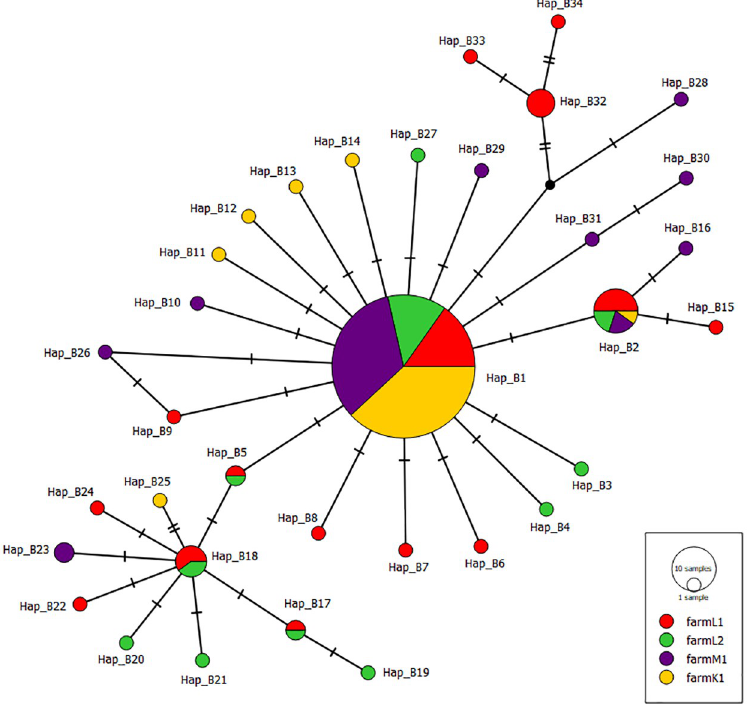
Fig 2. Median-joining haplotype network of Bathycoelia distincta for Cytb gene. Each haplotype is represented by a circle. Relative sizes of the circle indicate haplotype frequency. Color patterns demonstrate samples collected from different farms and regions of South Africa (Limpopo: farm L1 (n = 38), farm L2 (n = 28); Mpumalanga farm M1 (n = 45); Kwazulu-Natal farm K1 (n = 46)). Crossbars indicate one mutational step.